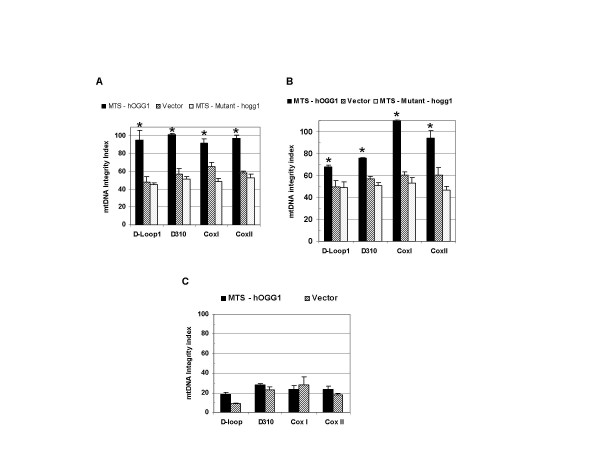
mtDNA integrity after oxidative damage exposure. MtDNA integrity of indicated mitochondrial regions in HeLa cells transfected with empty vector, MTS-hOGG1 and MTS-Mutant hogg1 and treated with (A) 400 μM of H2O2 for 2 h; (B) 28 μM of Adriamycin for 2 h and (C) 50 μM of 4-NQO for 1 h were analyzed by using quantitative real-time PCR amplification. The extent of decrease in mtDNA integrity was analyzed by calculating the mtDNA/nuclear DNA ratio, and normalizing to the untreated control set at 100%. The error bars represent standard deviation of each experiment done twice in triplicates. An asterisk indicates a significant difference (0.004 ≥ p ≥ 0.0001), when compared to the vector using Student's t test.